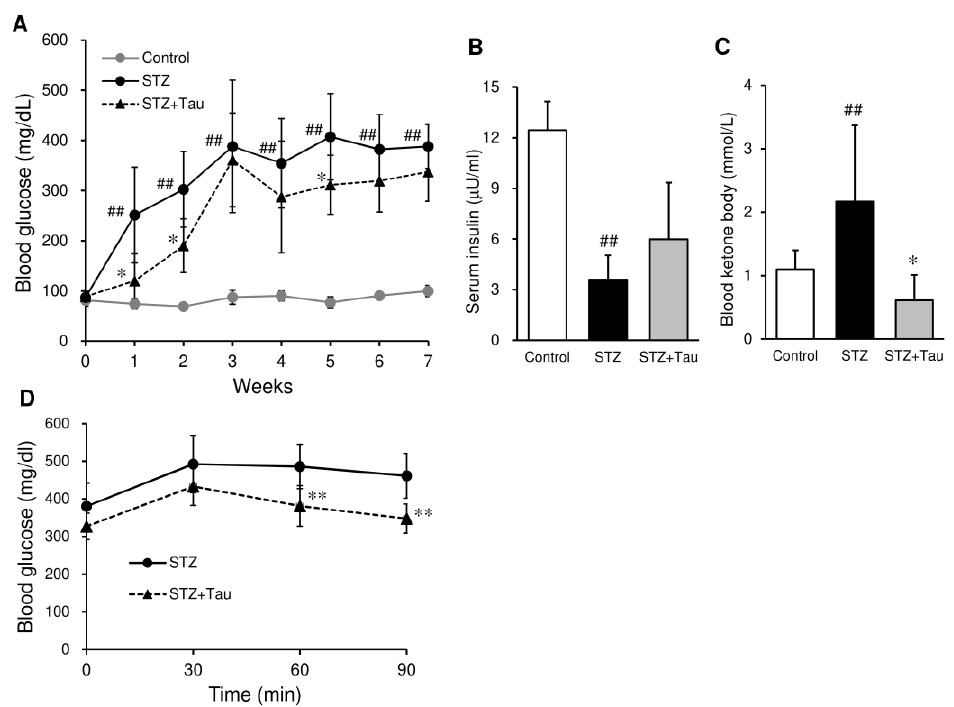
Figure 1. Changes in body weight in control, diabetic, and taurine-treated groups. Each value is expressed as the mean ± S.D. ( n = 8 – 12), ## p < 0.01 vs. STZ group.